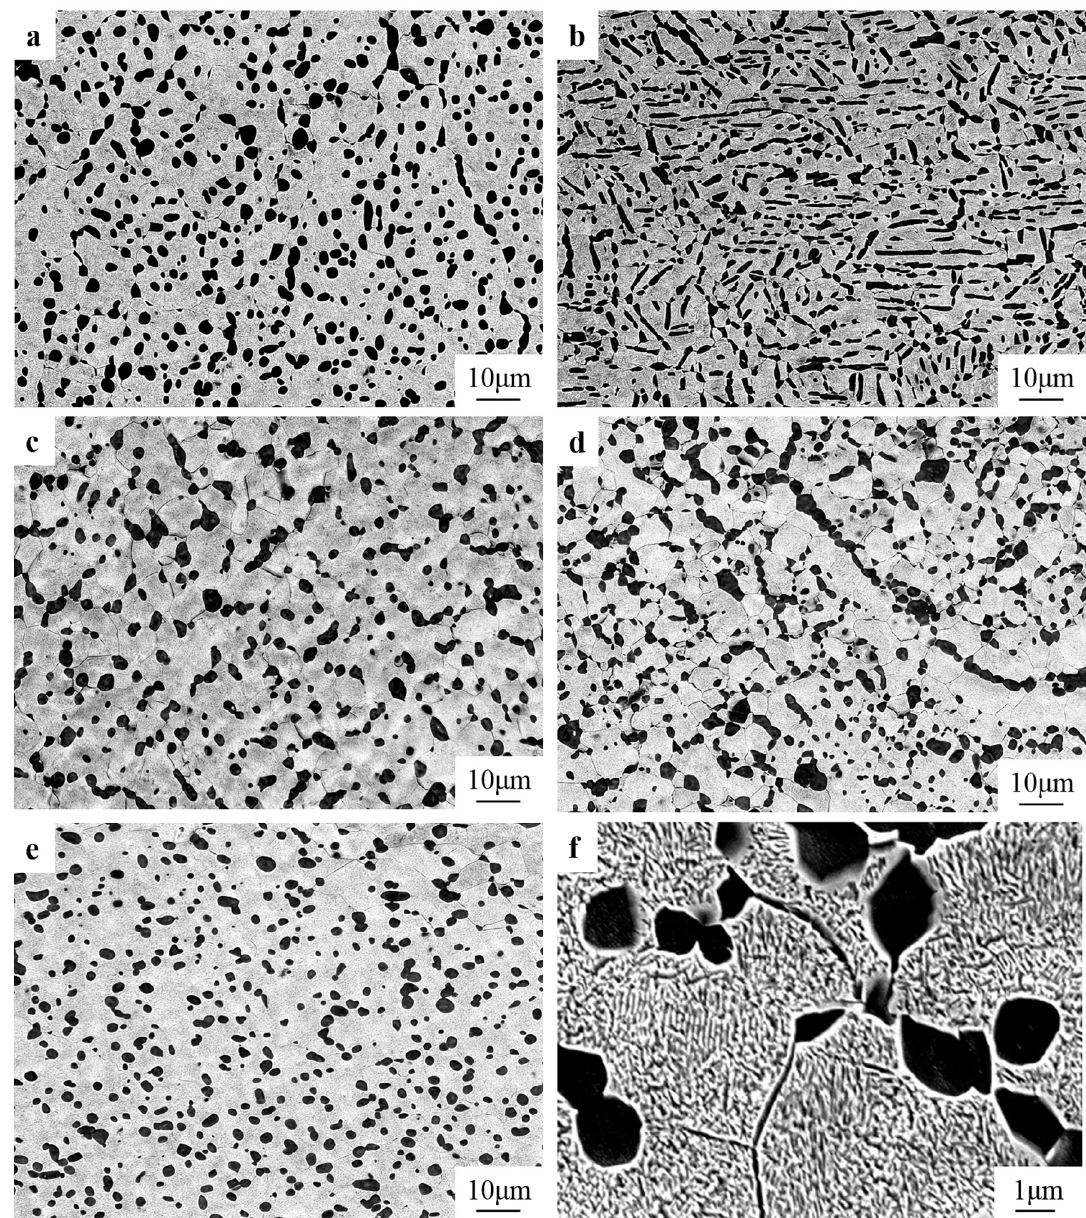
Figure 2. SEM micrographs of different samples cut from different regions: (a) S1; (b) S2; (c) S3; (d) S4; (e) S5; (f) typical secondary α phase For a better evaluation of the grain size and volume